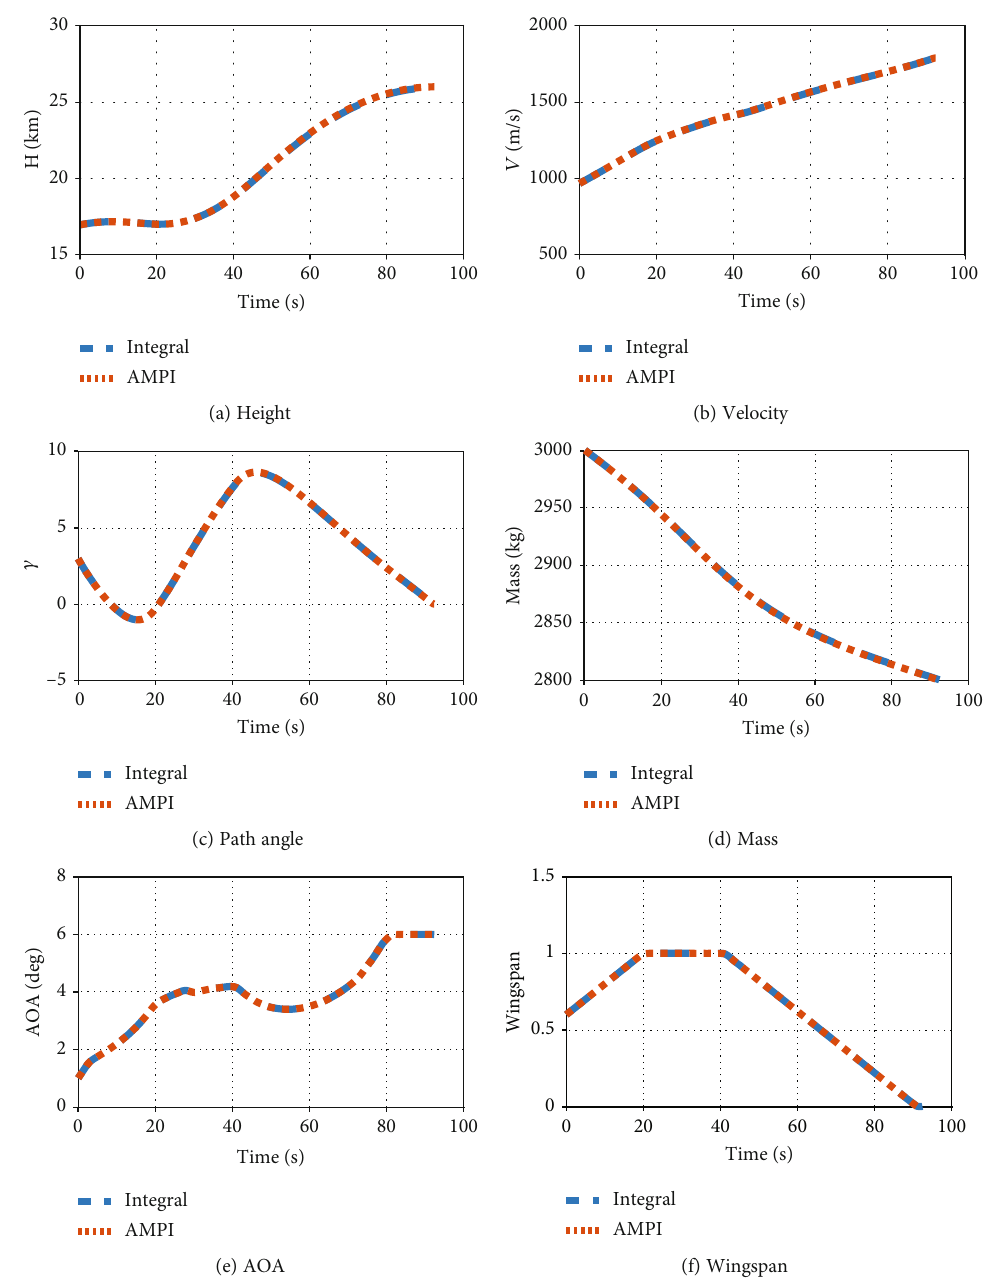
Figure 7: AMPI vs.